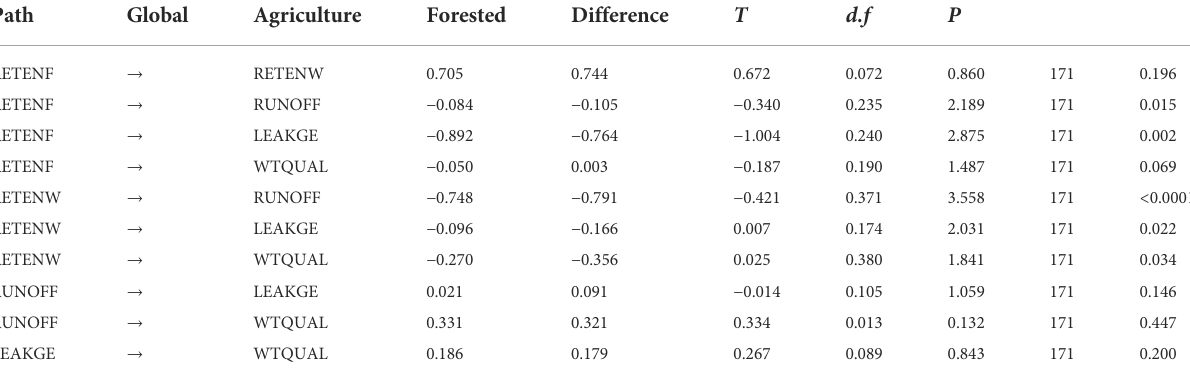
TABLE 9 Comparison of path coef fi cients between predominantly forested ( > 70% forested) and more agricultural watersheds. Estimates of Global pathcoef fi cients( ‘ Estimate ’ columninTable6)arepresentedalongwithdifferences,thebootstrapT-statisticofthedifference( T ),thedegreesof freedom and the associated p -value. Comparisons that were not signi fi cant grayed out for clarity.